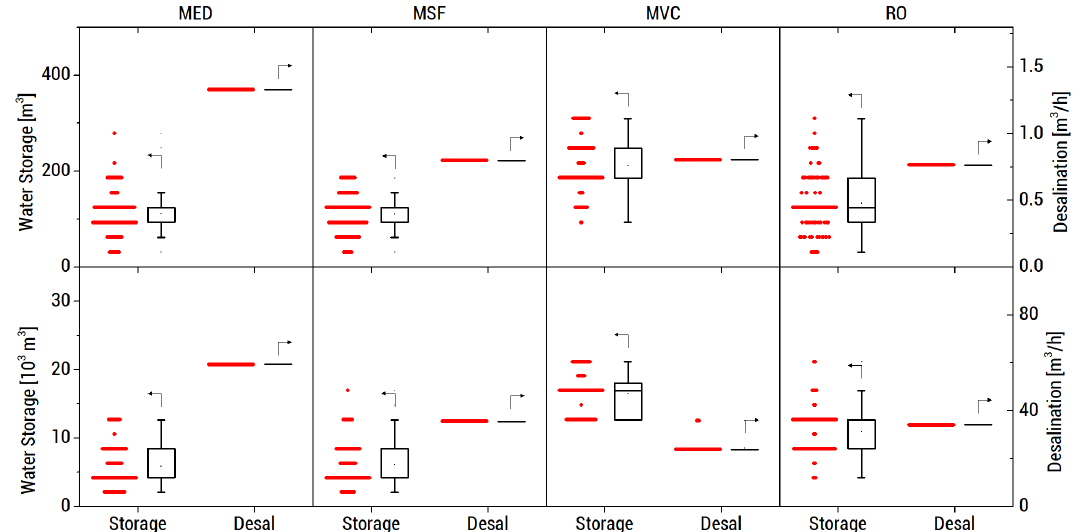
Figure 16. Distribution of optimum sizes of water storage and desalination unit on Camasusu Island ( top ) and Lubang Island ( bottom ) at − 25% overnight fuel price. There is high uncertainty in the optimum water storage sizes in all systems on both islands.